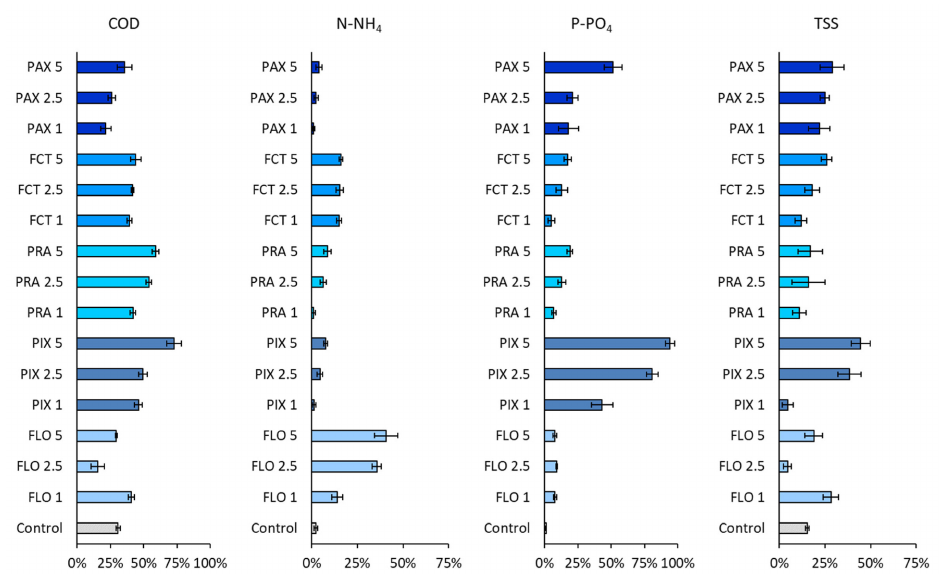
Figure 3. The effectiveness of pollutant removal from raw wastewater depending on the type and dose of